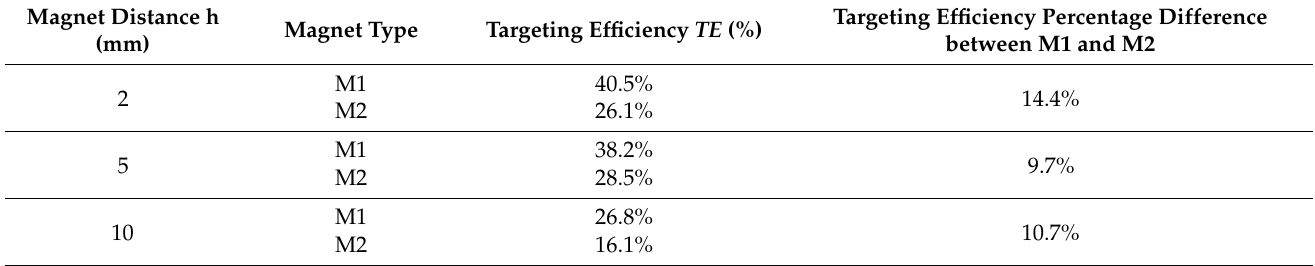
Table 11. Particle targeting efficiency ( TE ) in the artery bifurcation